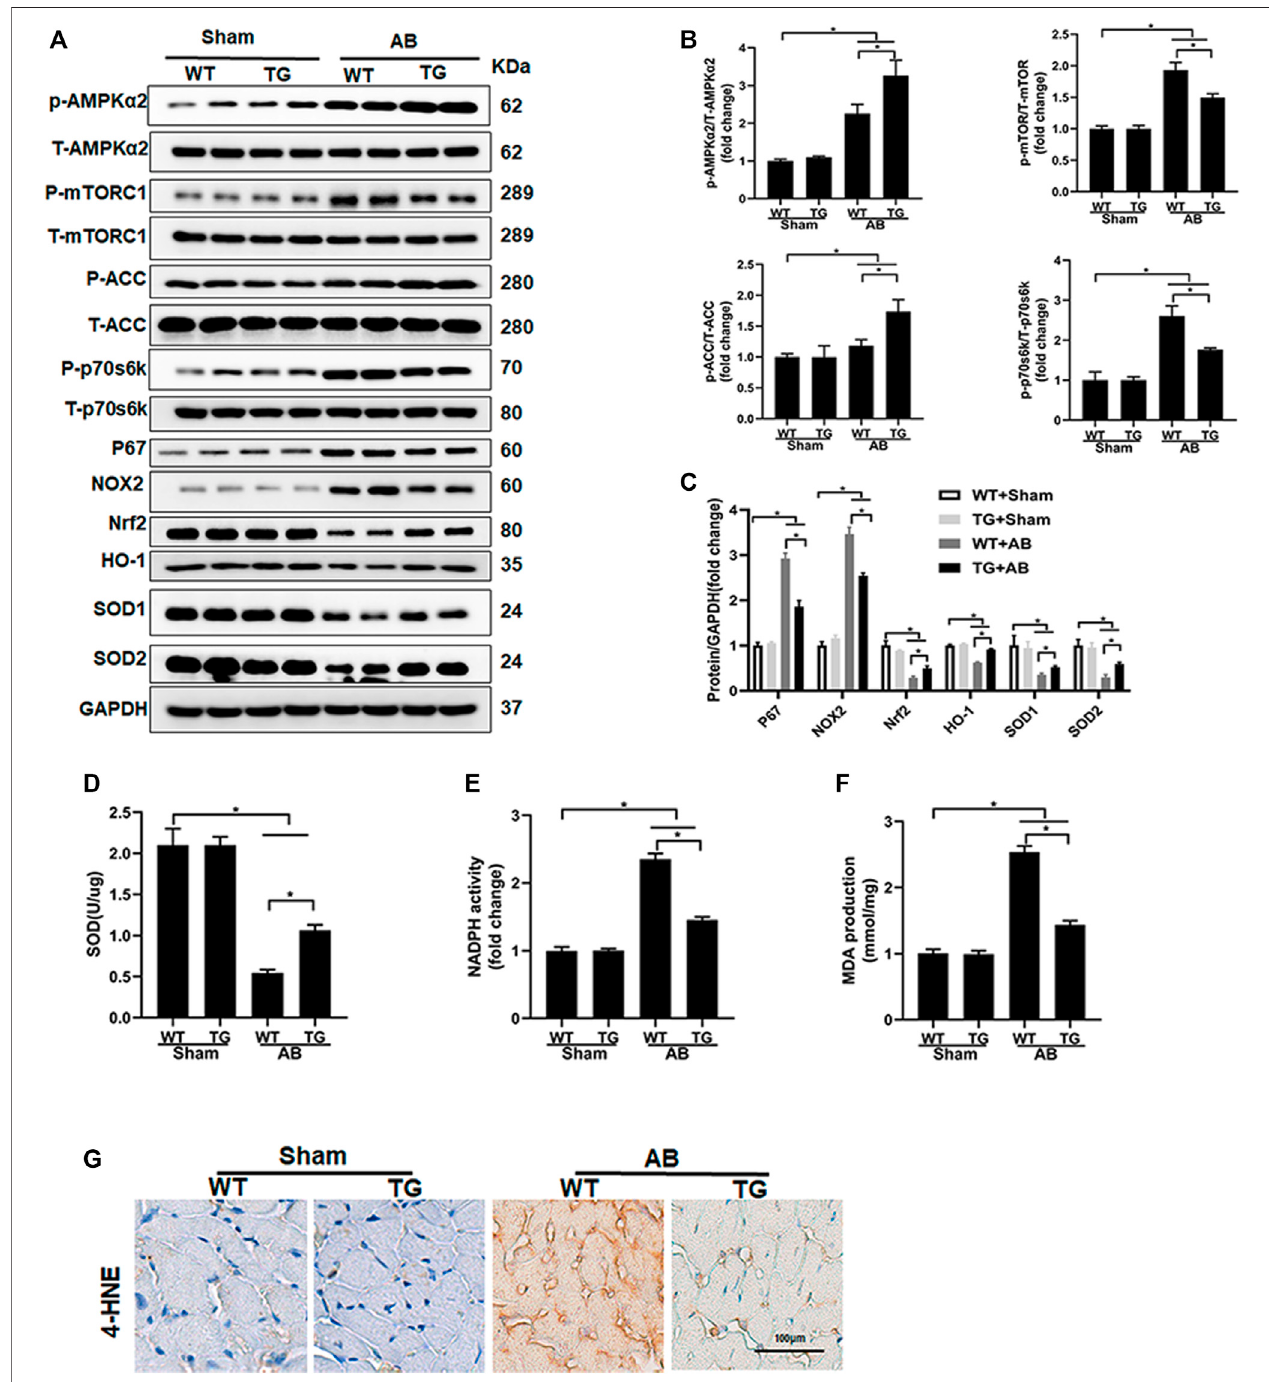
FIGURE 4 | Sesn2 overexpression activated the AMPK α 2 pathway and suppressed oxidative stress. (A) Representative Western blots of the phosphorylated and totalproteinexpression ofAMPK α 2,mTORC1,ACC,P70s6k,P67,NOX2,Nrf2,HO-1,SOD1, andSOD2at8 weeksafterABsurgery( n (cid:1) 6). (B,C) Quanti fi cation ofthe proteins. (D) Examination of SOD activity ( n (cid:1) 6), (E) Examination of NADPH activity ( n (cid:1) 6), (F) Examination of MDA accumulation ( n (cid:1) 6). (G) . Immunohistochemical staining for 4-hydroxynonenal (4-HNE). * p < 0.05 vs. indicated group. One-way analysis of variance (ANOVA) followed by Tukey post hoc tests were used for signi fi cance